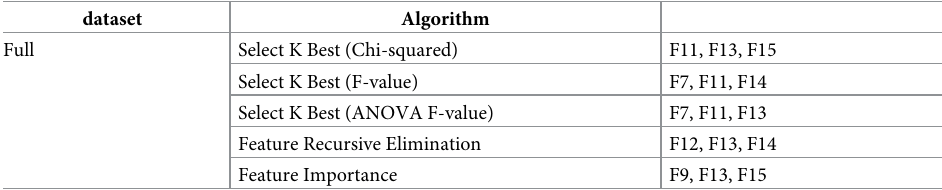
Table 7. Results of feature selection of the letter-recognition